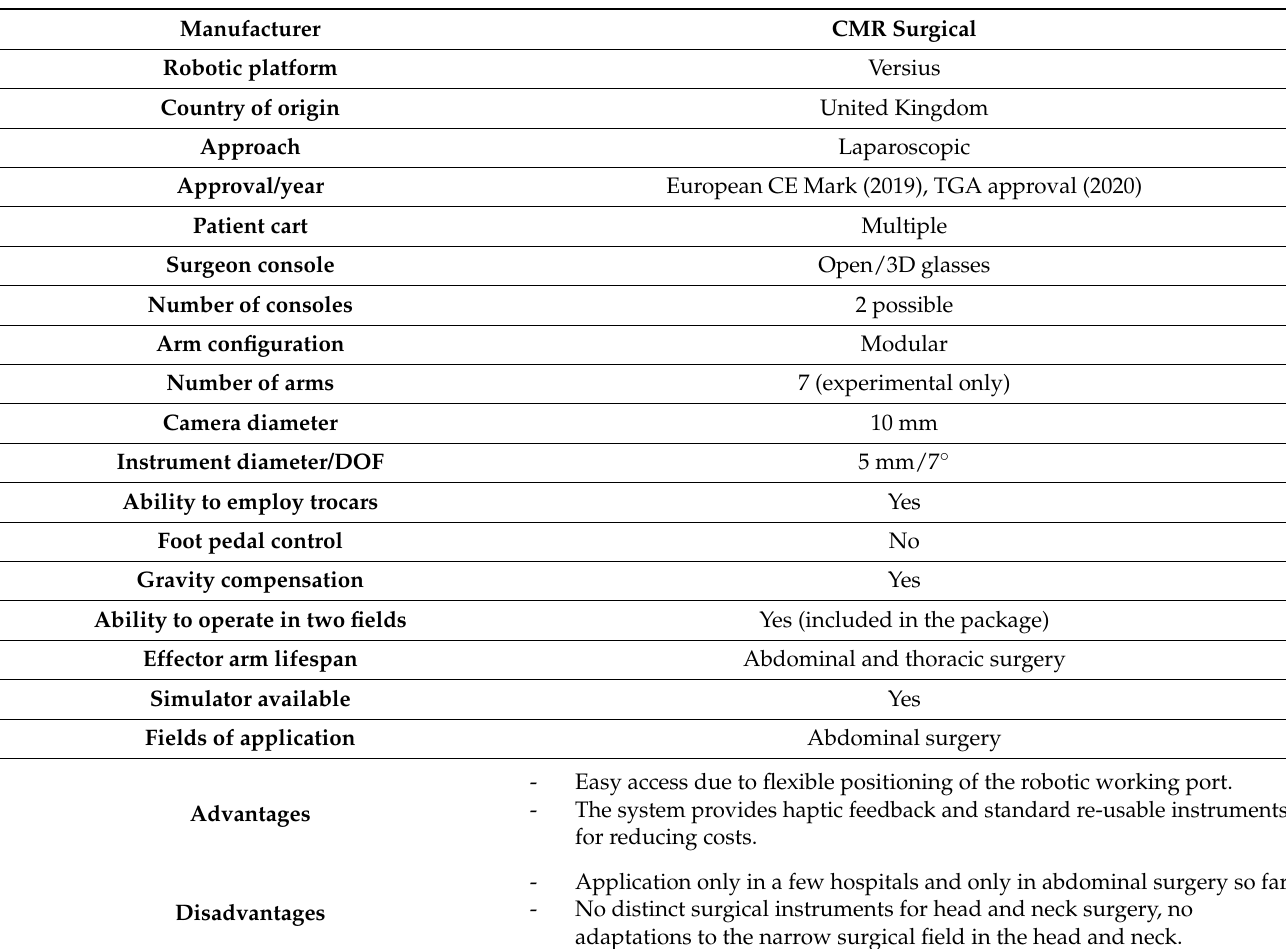
Table 1. Characteristics of the Versius robotic surgical platform (multi-port robotic system)